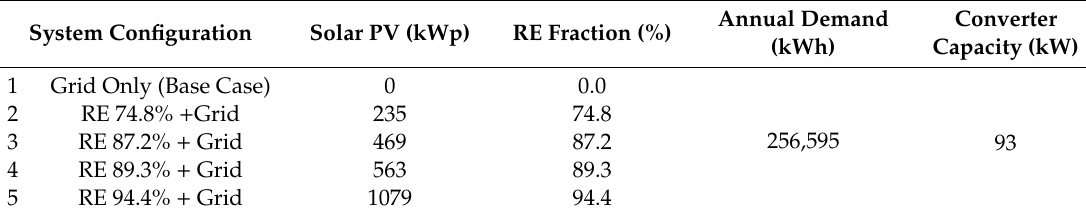
Table 3. Selected system configurations from the simulated results.